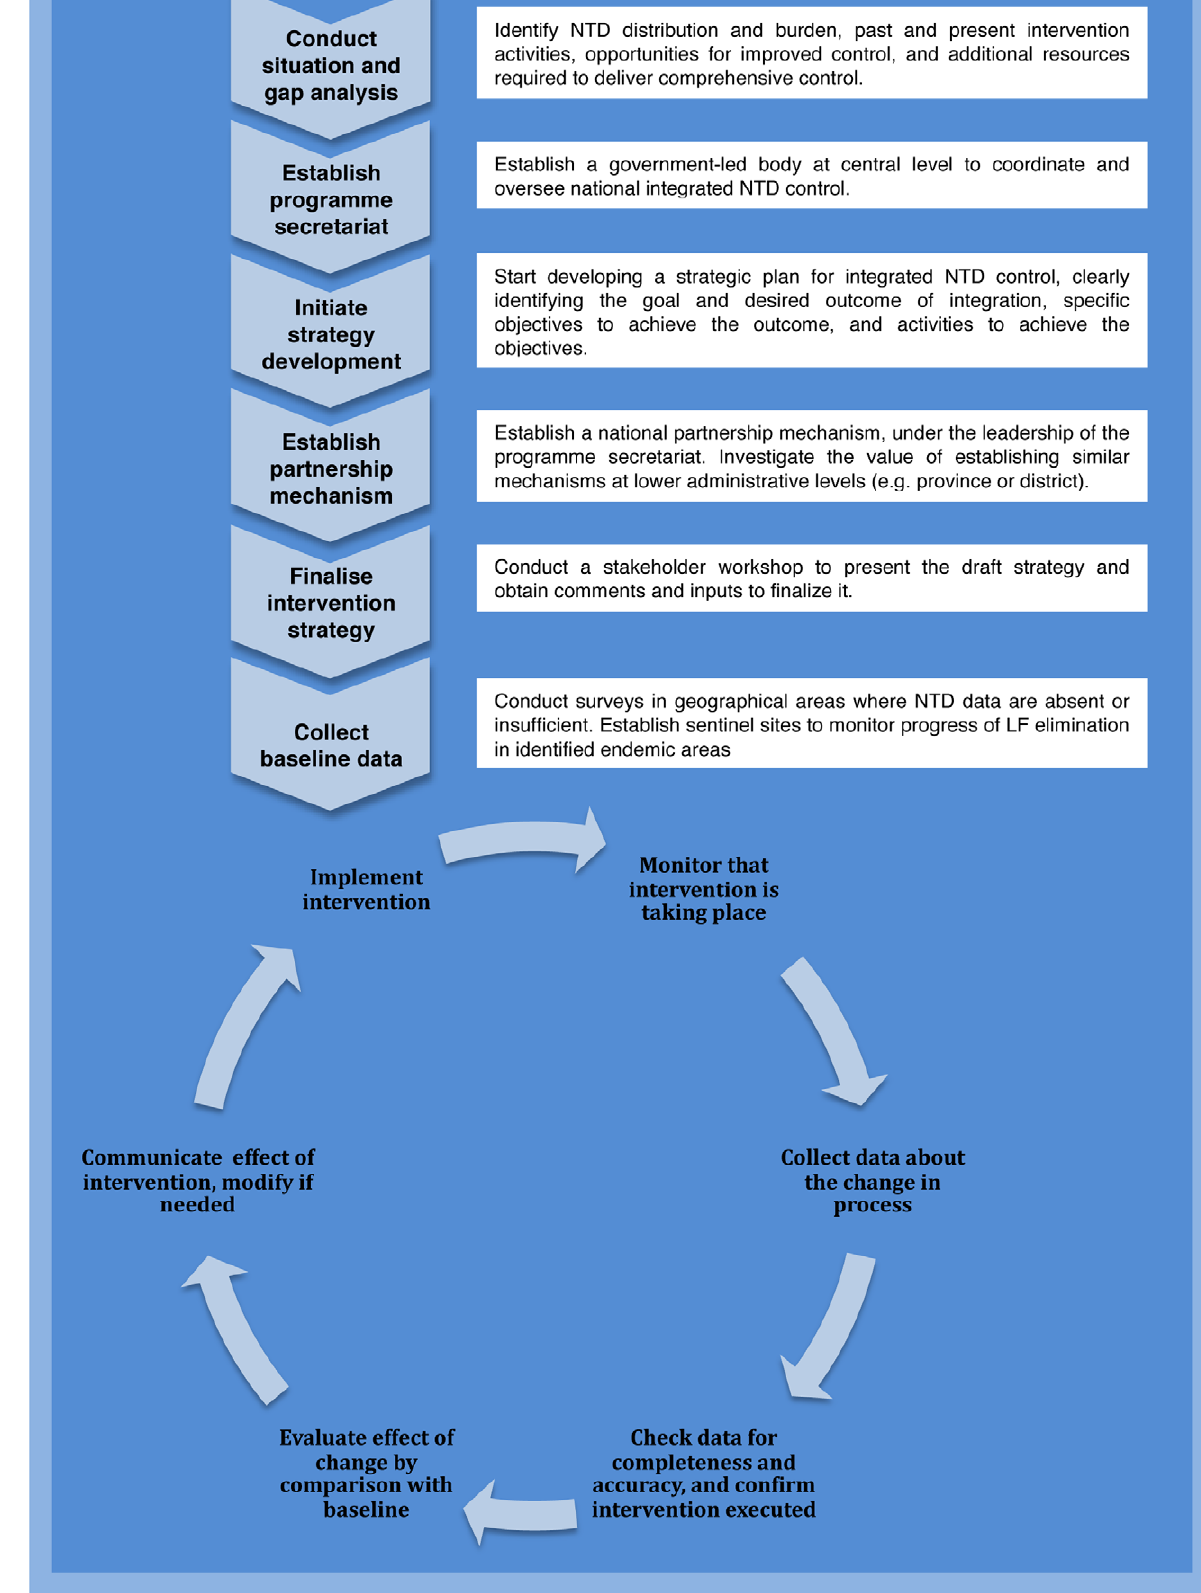
Figure 1. Key steps in establishing and running an integrated NTD control programme. Modified from [46].